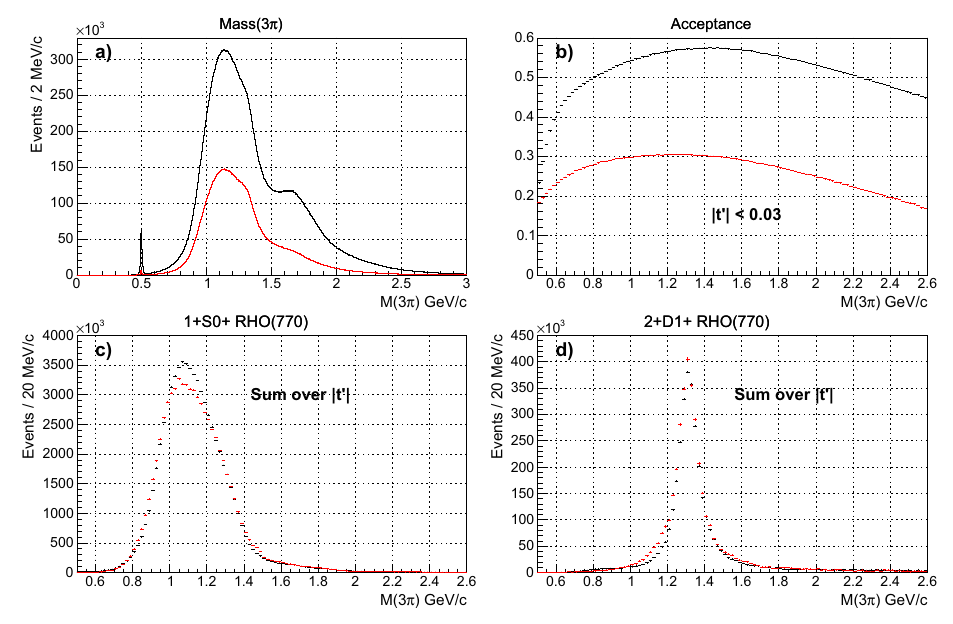
Figure 1. Graph of a) M (3 π ), b) acceptance, c) intensity of wave 1 + S 0 + ρ (770) π , d) intensity of wave 2 + D 1 + ρ (770) π . Color code: black for π + 2 π − , red (gray in b / w) for π − 2 π 0 final